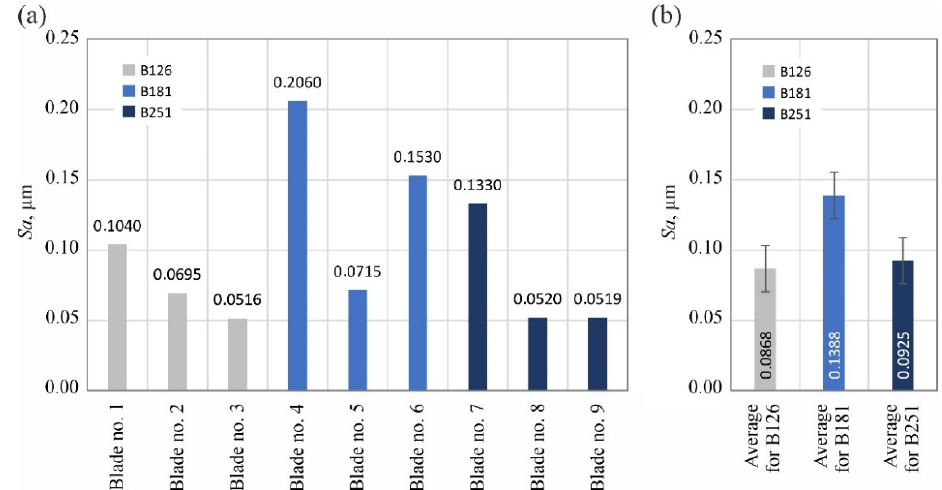
Figure 11. Changes in the arithmetic mean deviation of the surface Sa : ( a ) results for nine blades selected for surface texture measurements; ( b ) average values determined by the size of the cBN abrasive grain of the grinding wheel used (error bars represent the standard error equal to the standard deviation σ divided by the square root of the total number of samples).